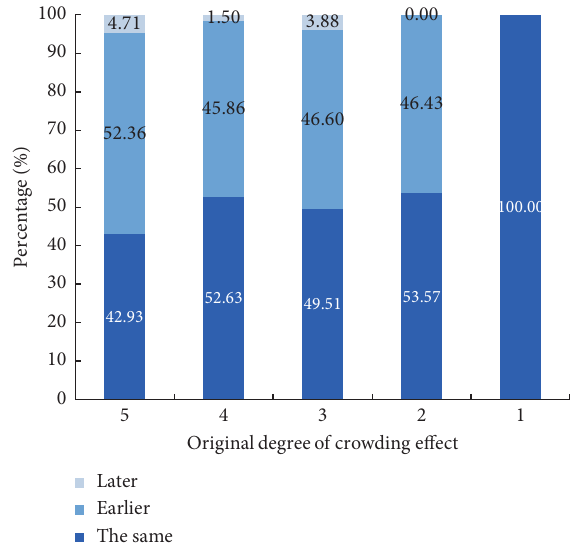
Figure 2: The willingness to switch departure